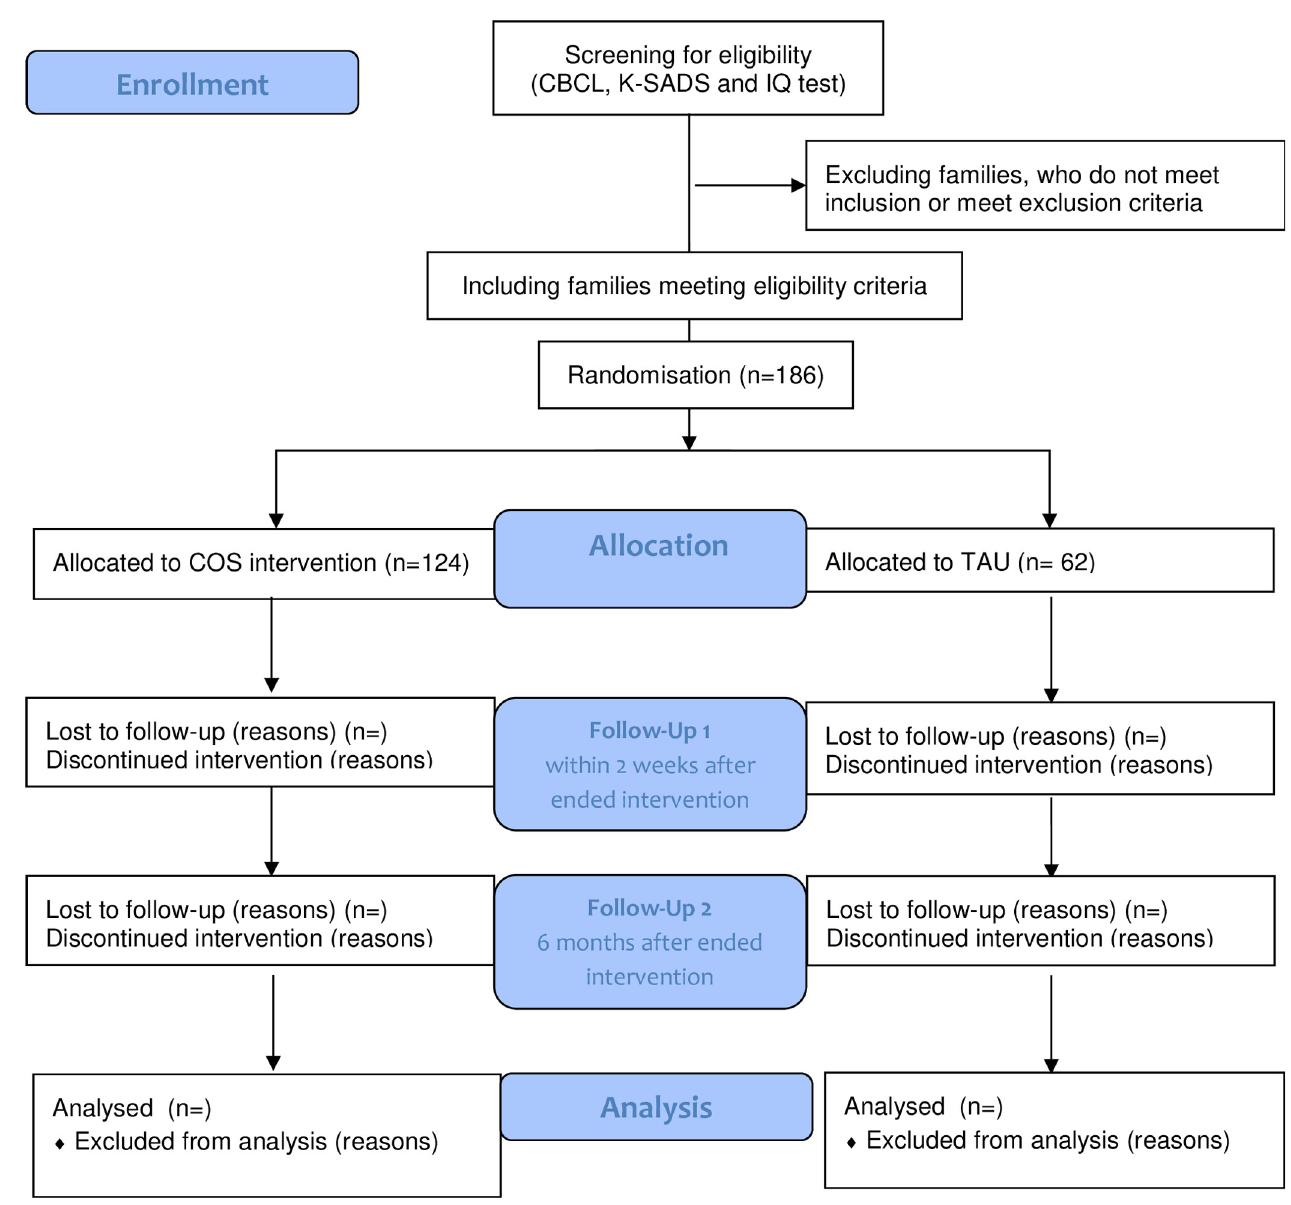
Fig 2. CONSORT flow diagram. Flowchart of the different phases of the COS-P trial.